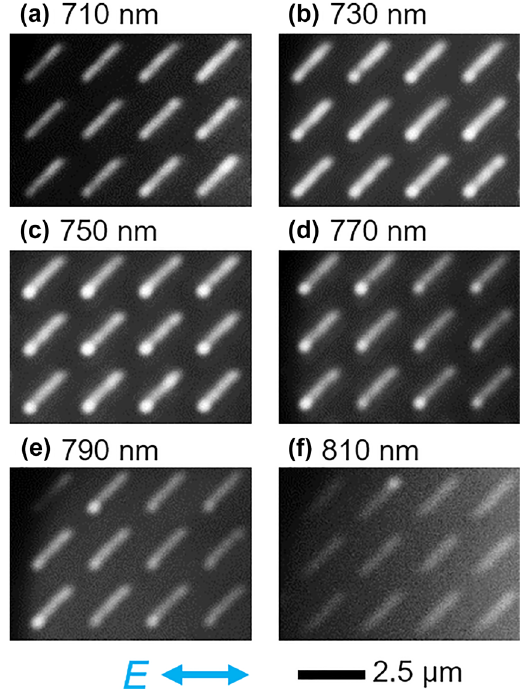
Figure 6: Wavelength dependence of the edge states in the 27 chains for the x -polarization. The center wavelengths of the filters are (a) 710, (b) 730, (c) 750, (d) 770, (e) 790, and (f) 810 nm.